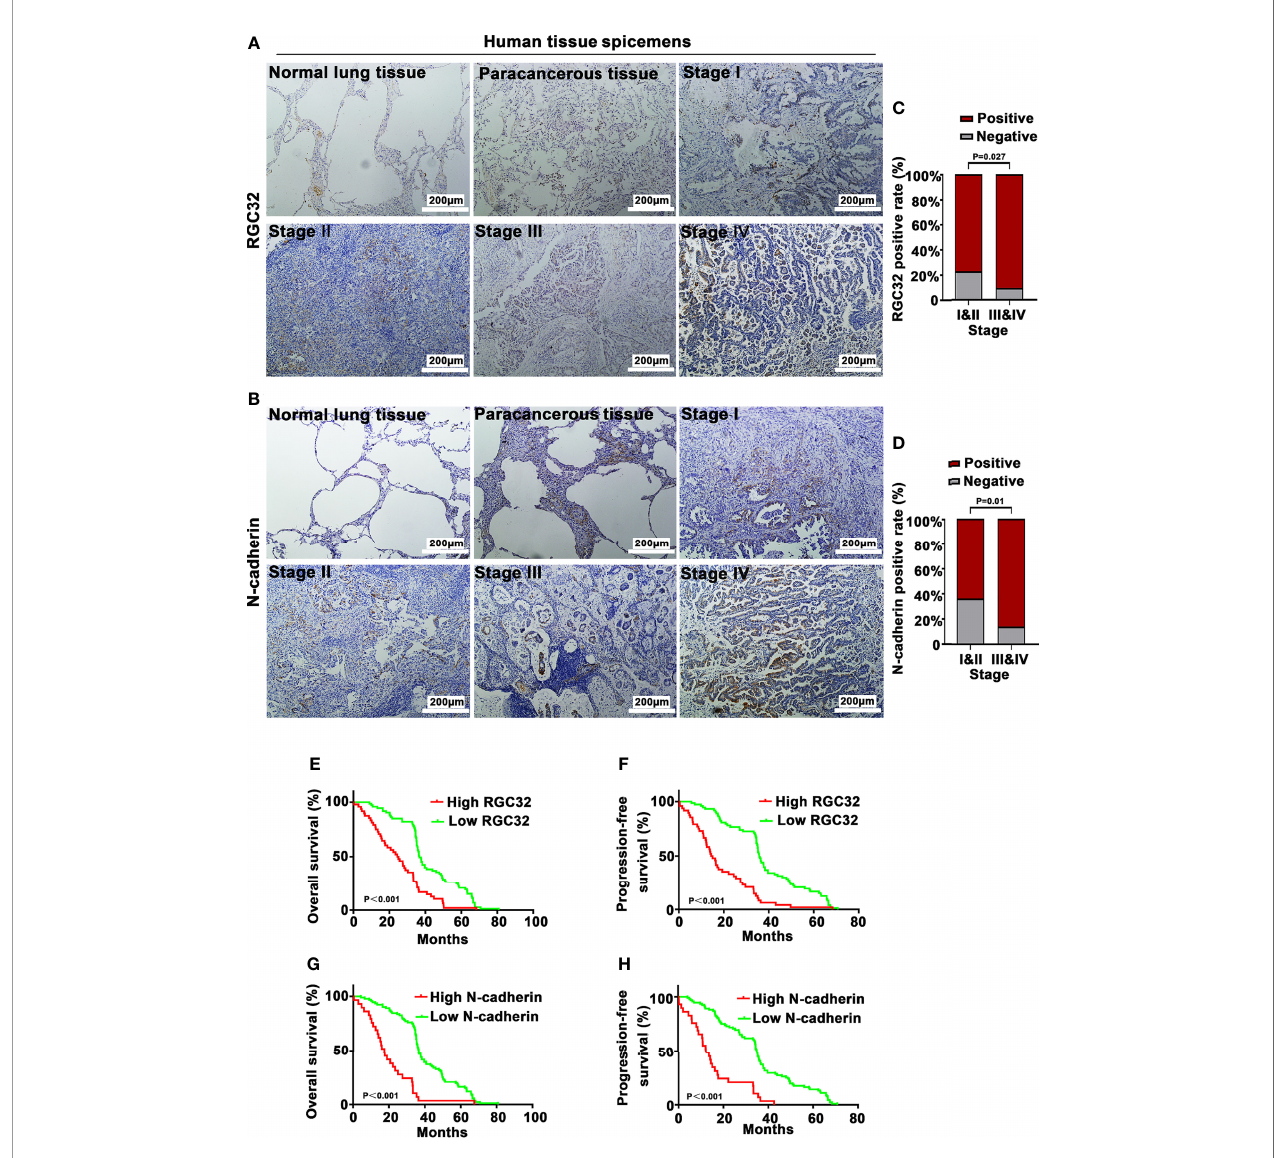
FIGURE 6 | RGC32 and N-cadherin expression and survival analysis of 121 lung adenocarcinoma patients. IHC to detect (A) RGC32 and (B) N-cadherin in normal lung tissue, paracancerous tissue, and different stages of lung adenocarcinoma. Representative images shown. Magni fi cation ×400. Percentages of (C) RGC32 and (D) N-cadherin expression in stages I & II and stages III & IV (n = 79 in stages I & II group, n = 42 in stages III & IV group). Kaplan – Meier plots of overall survival and progression free survival of patients with (E, F) high and low expression of RGC32, and (G, H) high and low expression of N-cadherin in primary lung cancer